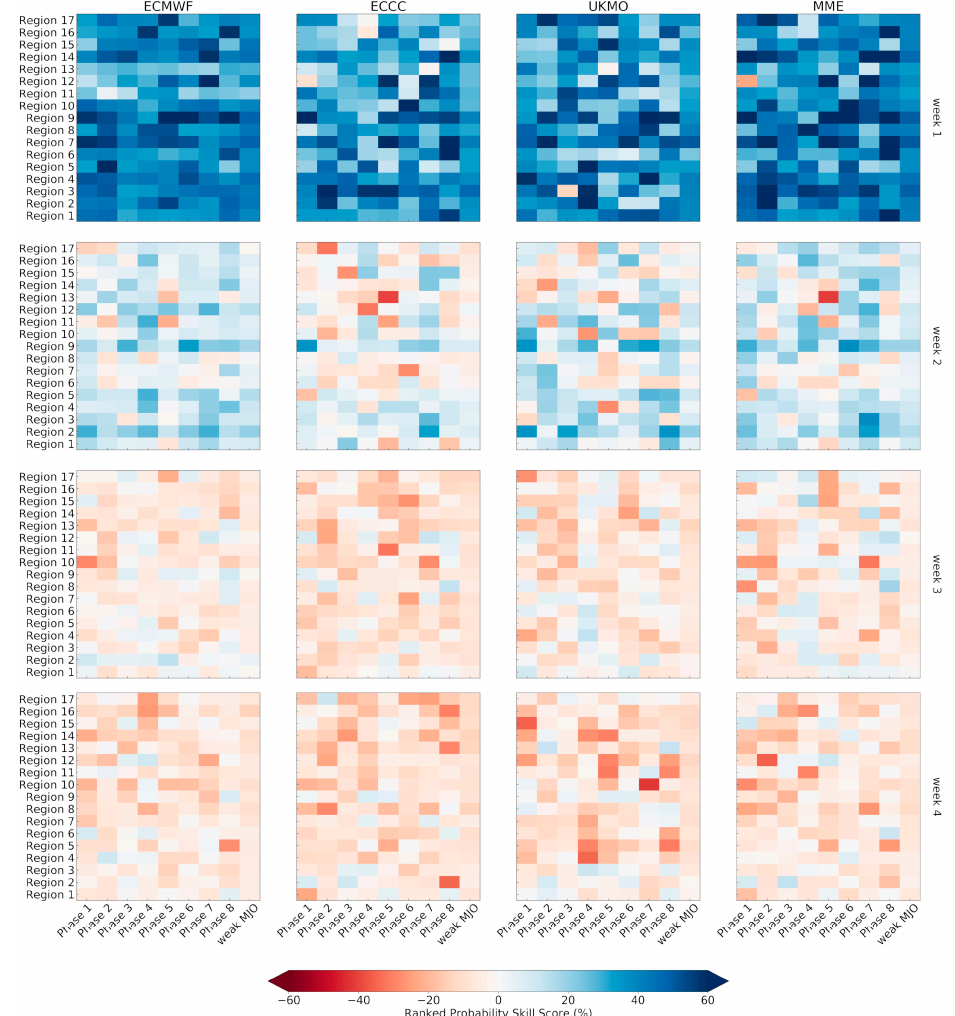
Figure 15. Ranked probability skill score of week 1, week 2, week 3, and week 4 precipitation forecasts in each of the MJO phases during the boreal summer monsoon.